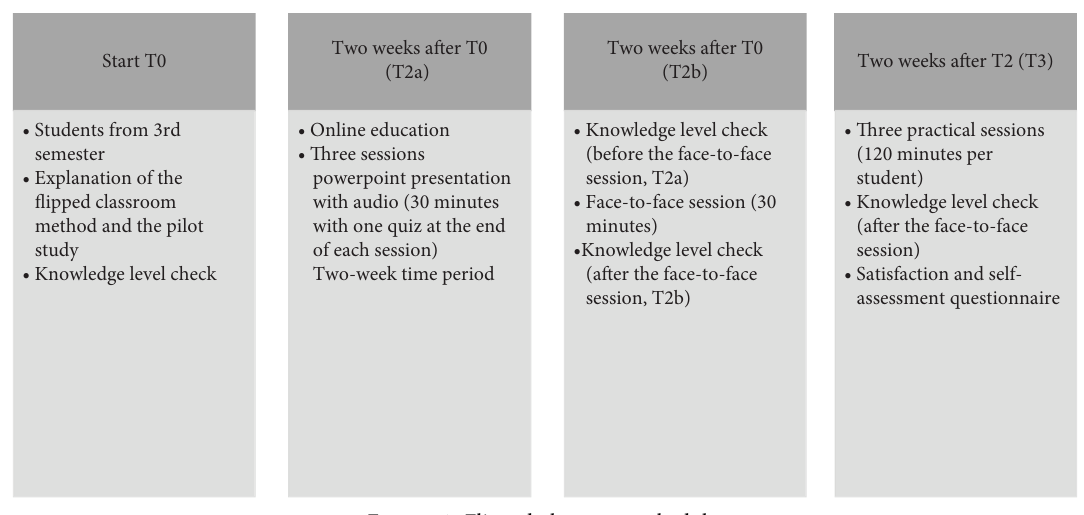
Figure 1: Flipped classroom schedule. Table 1: Descriptive statistics of the knowledge level between diferent time intervals (mean and standard deviation